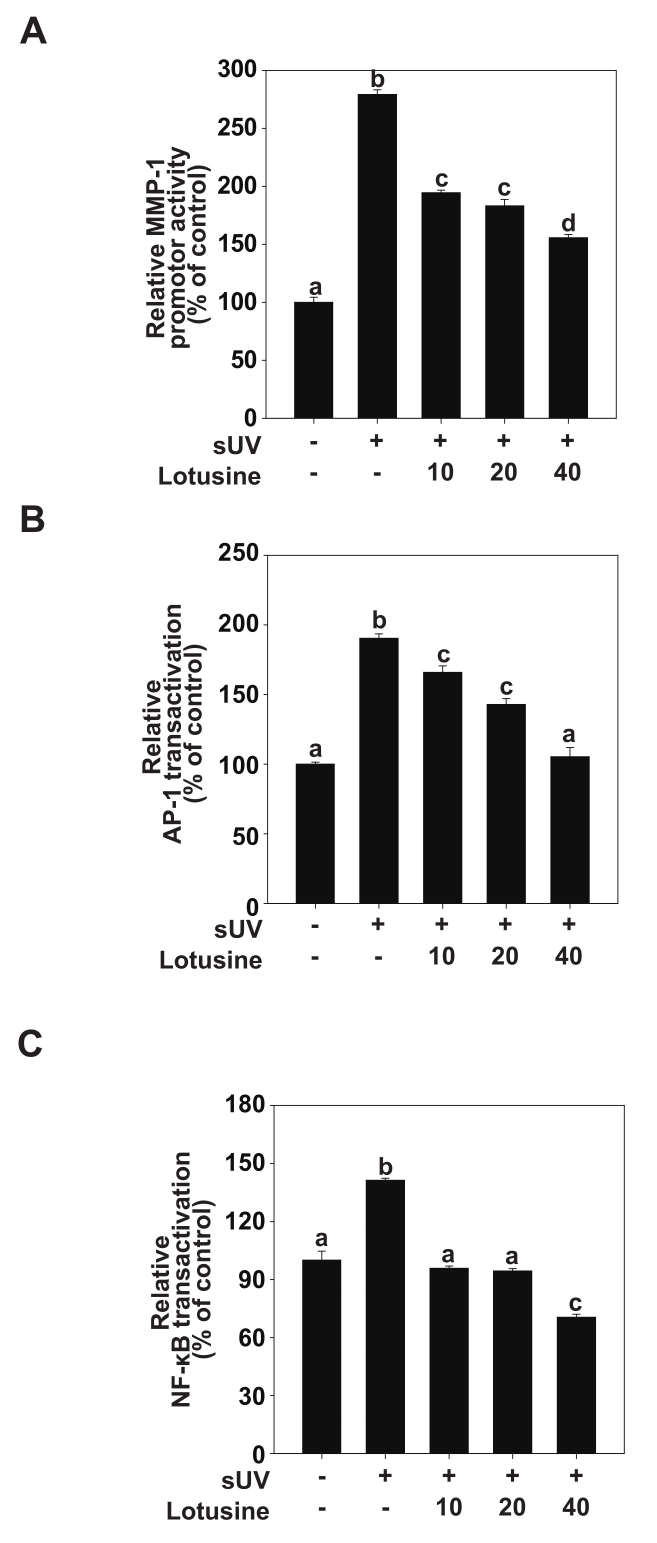
Figure 3. Lotusine suppresses solar ultraviolet (sUV)-induced MMP-1 transcription by inhibiting AP-1 and NF- κ B transactivation in HaCaT cells. ( A ) MMP-1 promoter activity was measured using the luciferase assay. Transactivation of AP-1 ( B ) and NF- κ B ( C ) was measured using the luciferase assay. Bars marked with different letters (a–d) significantly differ ( p < 0.05) according to Duncan’s multiple range test. MMP-1, matrix metalloproteinase-1; AP-1, activator protein; NF- κ B, nuclear factor kappa